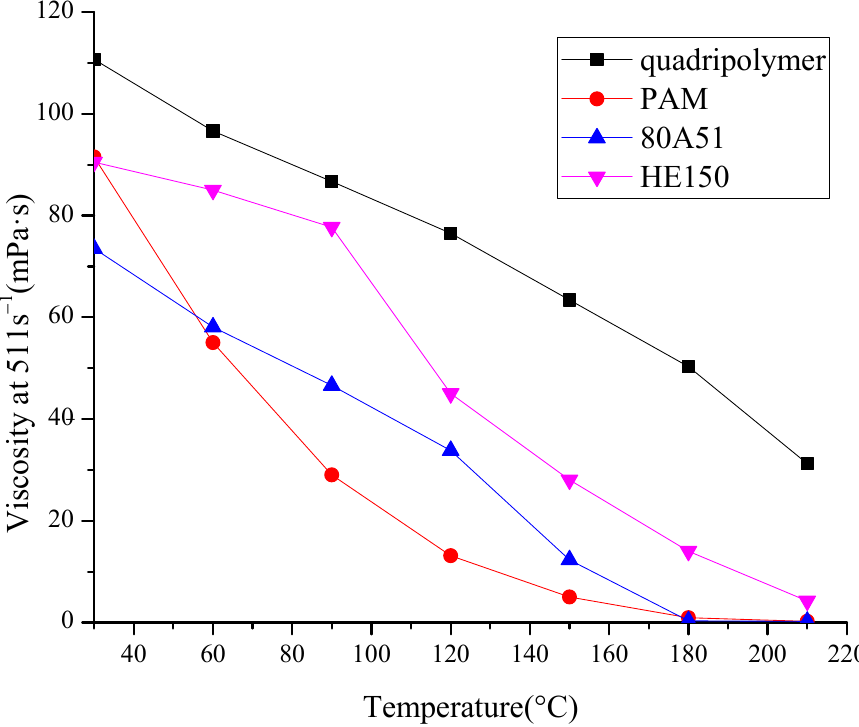
Figure 7. HTHP rheology curves of different polymer solutions.